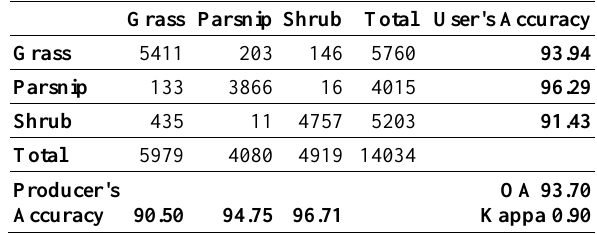
Table 3. Error matrix for accuracy assessment at Image Resolution 0.02